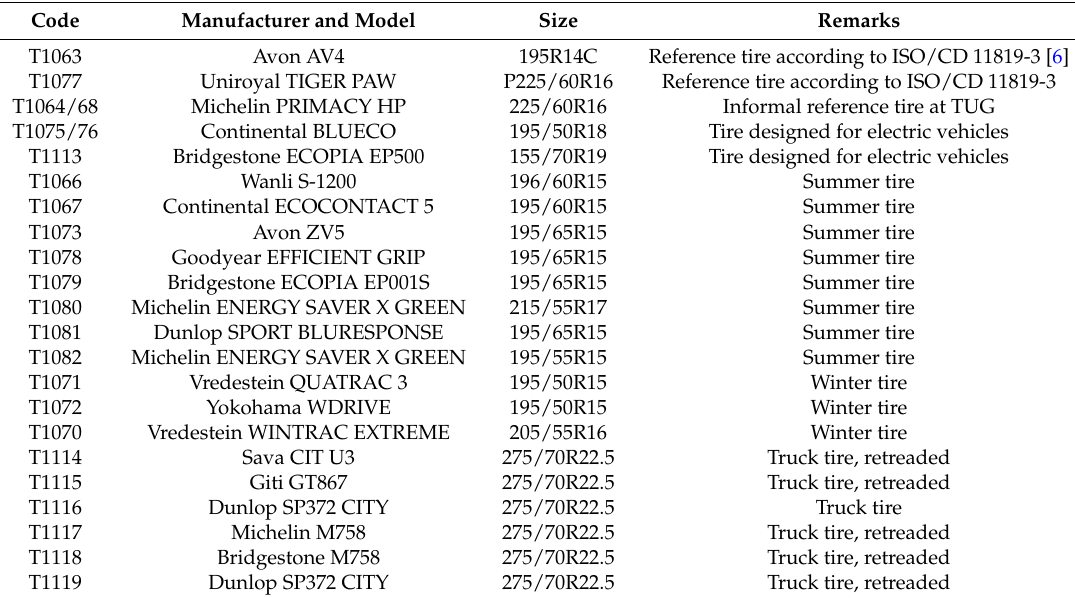
Table 2. Description of the tires.